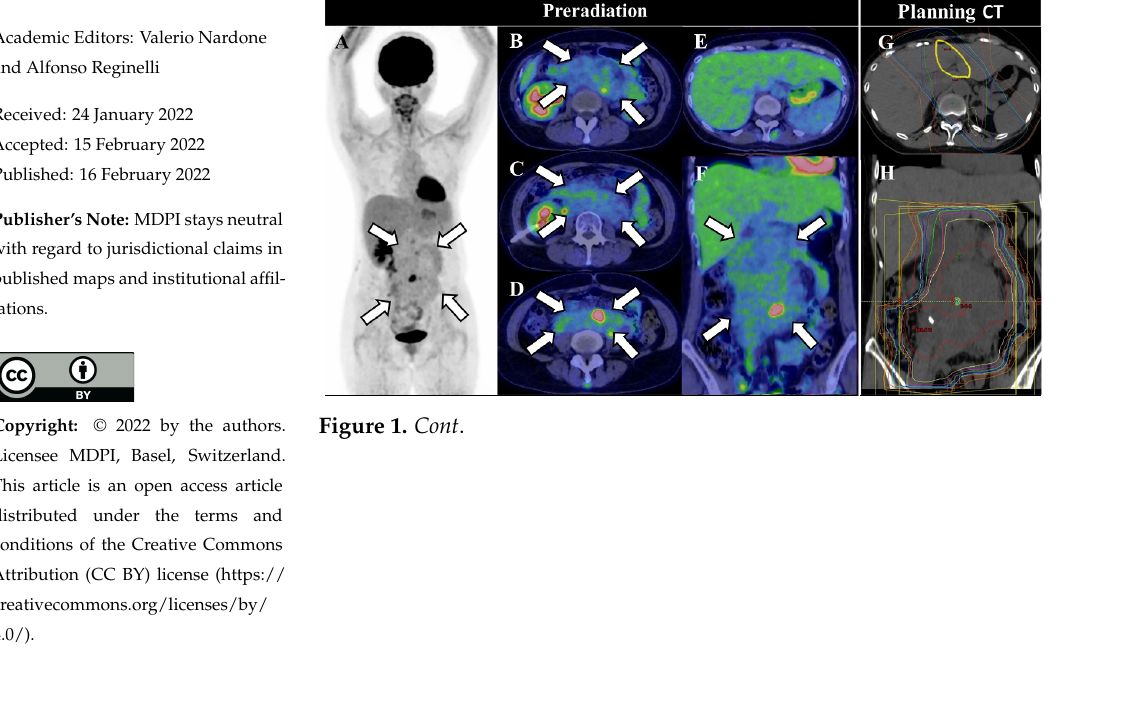
Figure 1. A 44-year-old woman with abdominal diffuse large B-cell lymphoma (DLBCL) received six courses of rituximab, cyclophosphamide, doxorubicin, vincristine, and prednisone. Treatment assessment 2-Deoxy-2-[ 18 F]fluoroglucose ([ 18 F]FDG) positron emission tomography/computed to- mography (PET/CT) showed high [ 18 F]FDG uptake scattered over a large mass in the abdomen ( A – F arrows). She received additional radiotherapy (RT) with 45 Gy in 25 fractions with three-dimen- sional conformal therapy ( G , H ). A second PET/CT performed for treatment assessment 1 month after irradiation showed a decrease in [ 18 F]FDG uptake in the abdominal mass, but a new focal ac- cumulation was observed in the left lobe of the liver, with a standardized maximum uptake of 7.0, suggesting hepatic infiltration of the DLBCL ( I – K ). Ethoxibenzyl (EOB)–magnetic resonance imag- ing (MRI) showed slight T2 hyperintensity ( L ) and decreased EOB uptake in the hepatocellular phase ( M ). Diffusion-weighted imaging (DWI) showed low intensity ( N ). Compared with the pre- treatment planning CT images, it can be recognized that the liver lesion coincides with the area of 90% of the prescribed dose, i.e., the area of >40.5 Gy ( G yellow line), and that the highest dose area has the highest [ 18 F]FDG avidity ( I – K arrows) and lowest EOB uptake ( M arrow). Seven months after irradiation, [ 18 F]FDG uptake in the lesion had decreased ( O , P ), which was consistent with ra- diation-induced liver disease (RILD). No elevations in liver enzymes or soluble interleukin-2 recep- tors were observed during the study period. RILD is usually asymptomatic and not associated with